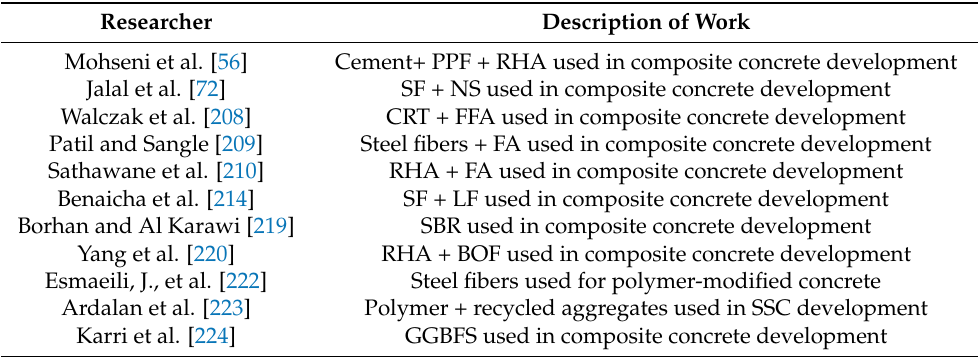
Table 2. Materials utilized in different polymer-type